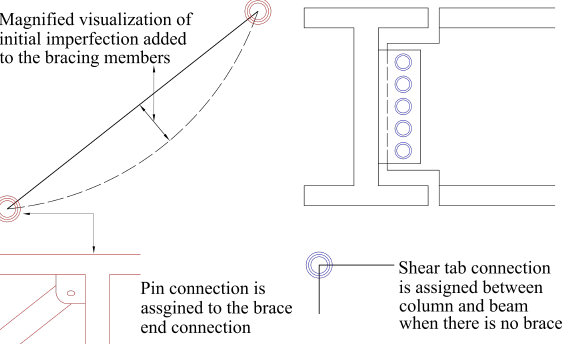
Figure 6. Visualization of joint element and imperfection in braces.